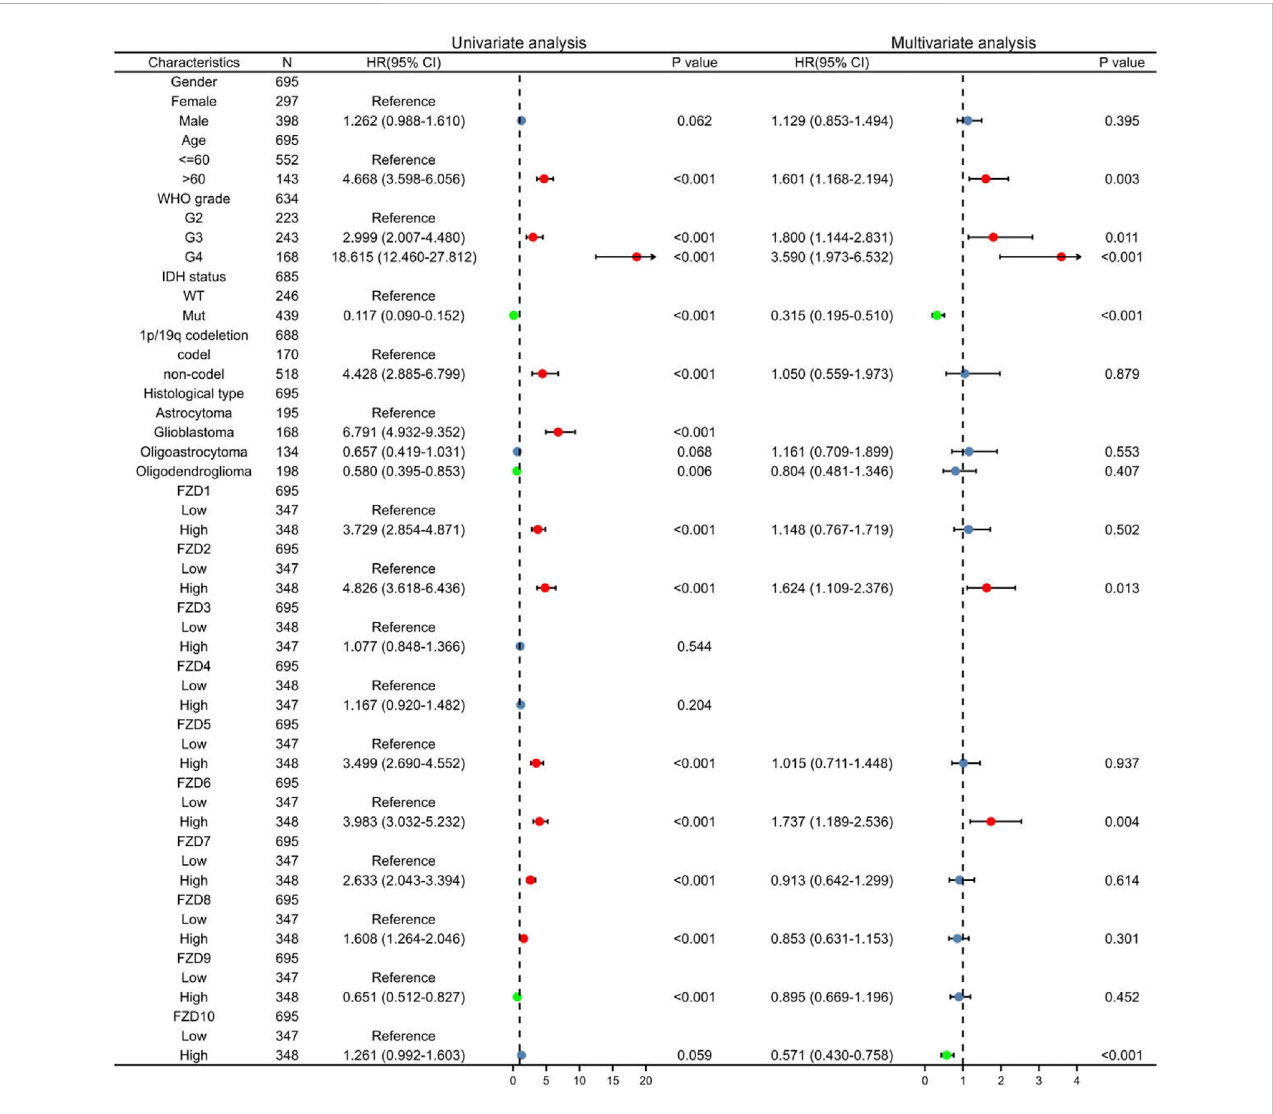
FIGURE 4 Univariate and multivariate Cox regression analysis. Red dots indicate disadvantageous factors (HR > 1 and p < 0.05); green dots indicate protective factors (HR < 1 and p < 0.05).